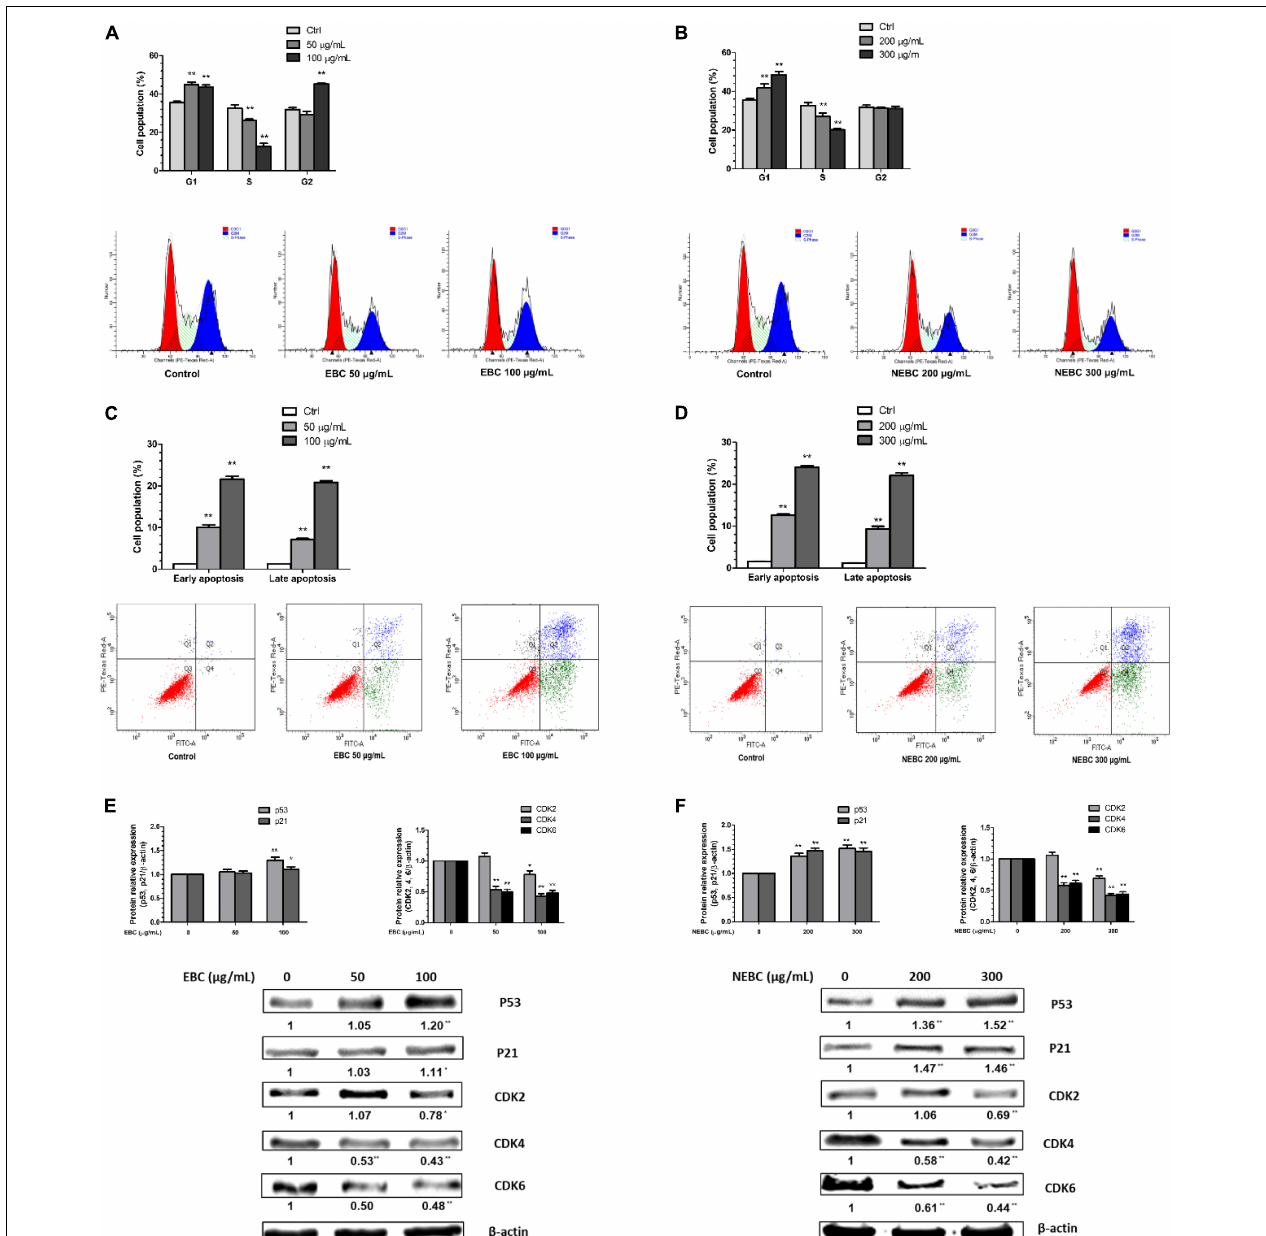
FIGURE 3 | Quantification of cell cycle after treatment of EBCs (A) and NEBCs (B) and the representative DNA histogram. Quantification of early and late apoptosis after treatment of EBCs (C) and NEBCs (D) and the representative Annexin V/PI co-staining dot plots. Effects of EBCs (E) and NEBCs (F) on the protein expression of tumor suppress genes and cyclin-dependent kinase in HCT 116 cells, as well as their representative image. * indicates P < 0.05 and ** indicates P < 0.01, when compared to the untreated control